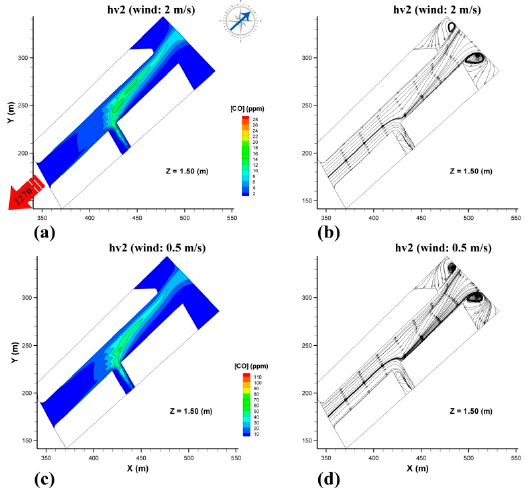
Figure 10. CO concentration contours (ppm) and streamlines in the hypothetical case hv2 for 2 m/s in ( a , b ) and for 0.5 m/s in ( c , d ). Traffic and wind direction are marked with red and blue arrows, 2 m / s in ( a , b ) and for 0.5 m / s in ( c , d ). Tra ffi c and wind direction are marked with red and blue respectively. arrows, respectively.